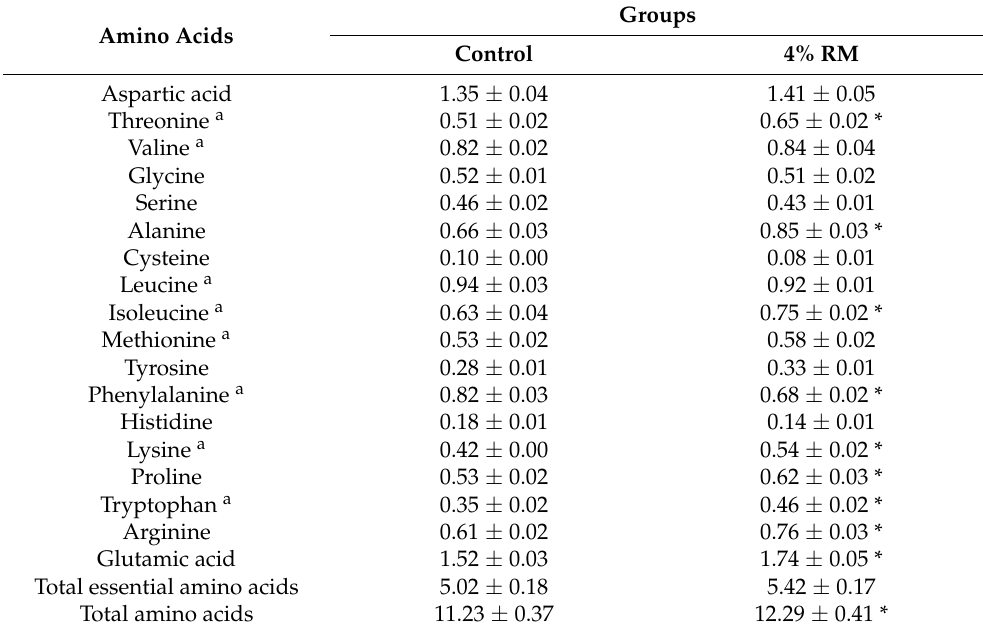
Table 3. Amino acid composition of the P. ostreatus mycelium grown on potato dextrose agar (%, dry weight basis). * indicates a significant difference at p < 0.05 compared with the control group. a The essential amino acids.